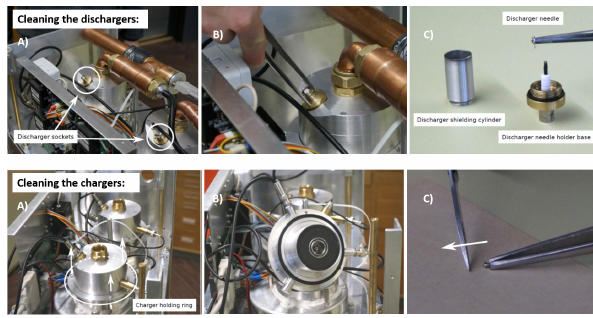
Figure 12. Opening and cleaning the dischargers (upper row) and the chargers (bottom